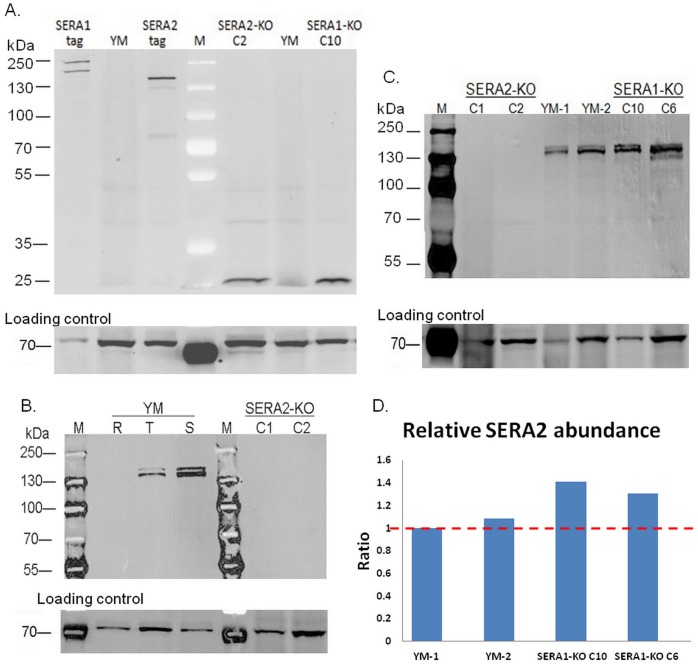
Western blot analysis using peptide antibody against SERA2.A. Presence of GFP in different parasite schizont extract (YM, SERA1-tag, SERA2-tag, SERA1-ko C10 and SERA2-ko C2 lines) was detected using primary chicken anti-GFP antibody and secondary 488@goat anti-chicken.IgG (H+L); while presence of Hsp70 in the same membrane was detected by primary anti-Hsp70 and secondary 549@goat anti-mouse lgG (H+L) as loading control at the lower panel. B. Presence of SERA2 in different parasite extract (YM: ring extract, trophozoite extract and schizont extract; SERA2-ko: schizont extract of C1 line and C2 line) was detected using primary peptide antibody 4209 and secondary 649@goat anti-rabbit IgG (H+L); while presence of Hsp70 in the same membrane was detected by primary anti-Hsp70 and secondary 488@goat anti-mouse lgG as loading control at the lower panel. C. Presence of SERA2 in different parasite schizont extract (YM, SERA2-ko C1 and C2 lines, and SERA1-ko C10 and C6 lines) was detected using primary peptide antibody 4209 and secondary 649@goat anti-rabbit IgG (H+L); while presence of Hsp70 in the same membrane was detected by primary anti-Hsp70 and secondary 549@goat anti-mouse lgG as loading control at the lower panel. D. Band intensities corresponding to SERA2 and Hsp70 in the western blot shown above (Fig 3C) were measured, and the median intensities for bands corresponding to Hsp70 were used for normalization in individual sample to obtain the relative SERA2 expression, and then the relative SERA2 expression ratio was calculated with one of the YM sample as the reference.